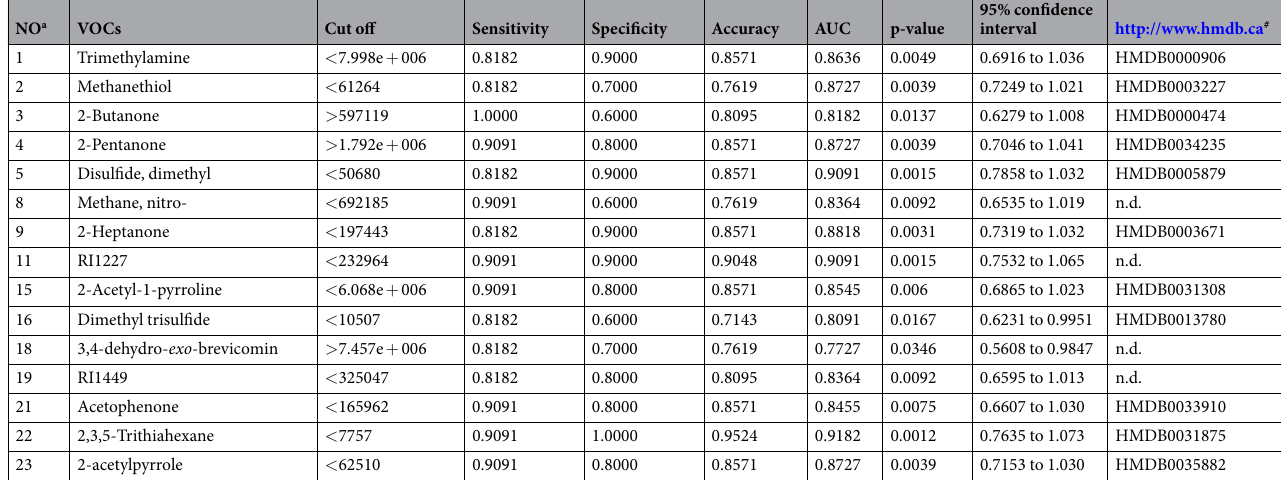
Table 2. ROC evaluations of urinary organic compounds (VOCs) showing differential levels between kindled (n = 11) and sham-operated (n = 10) mice. The absolute values of fifteen VOCs showing significant differences between kindled and sham-operated mice ( p < 0.05) as shown in Table 1 were evaluated by ROC analysis. a Number described in Table 1. 3,4-dehydro-exo-brevicomin showed a fair ROC curve (AUC < 0.8);